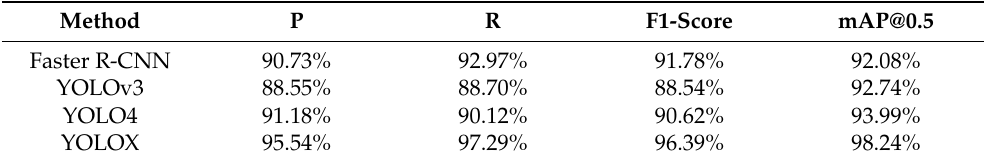
Table 3. Comparison of test results of different models under the test dataset CPD. Method